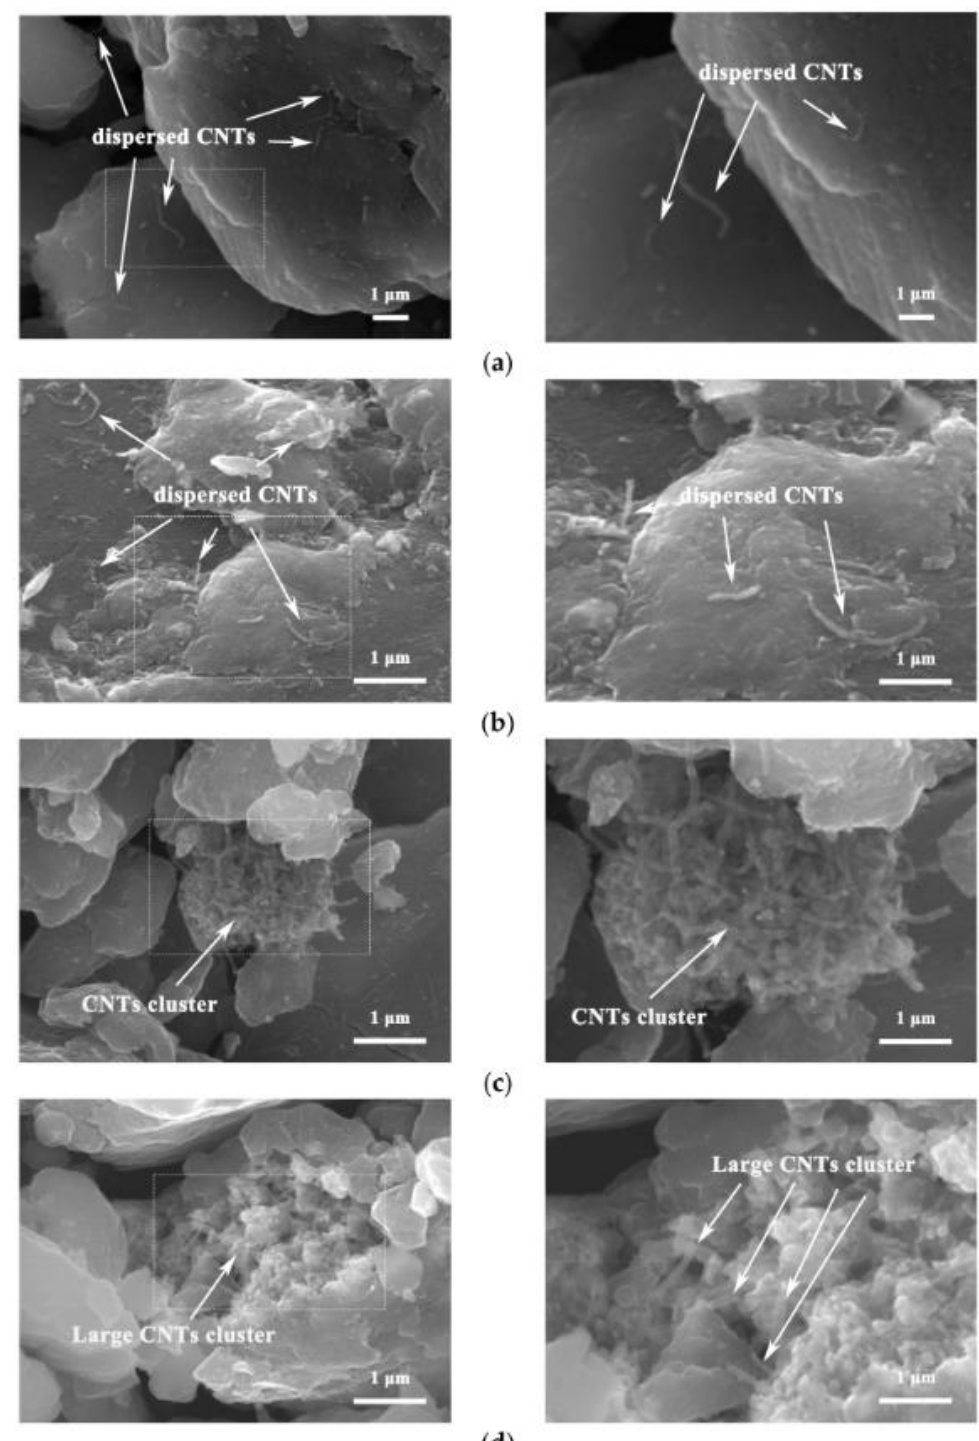
Figure 8. The SEM images of CNTs/refined-AZ61 composites: ( a ) 0.5% CNTs, ( b ) 1% CNTs, ( c ) 1.5% CNTs, ( d ) 2% CNTs. Reprinted from Ref. [11]. Copyright 2022 by the authors. Licensee MDPI, Basel,